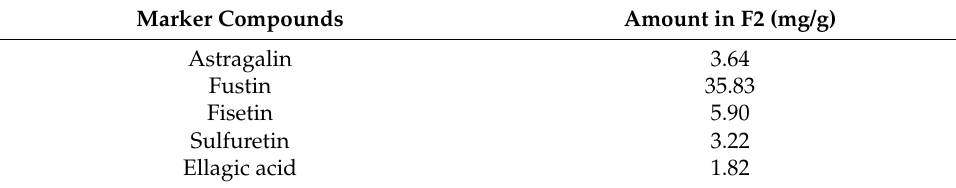
Table 3. Content of marker compounds in